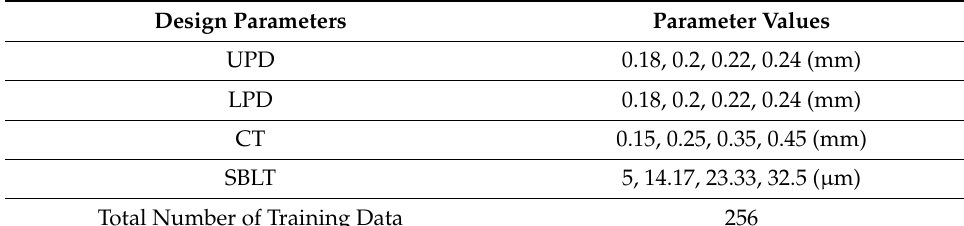
Table 6. Design parameters for 256 training data.